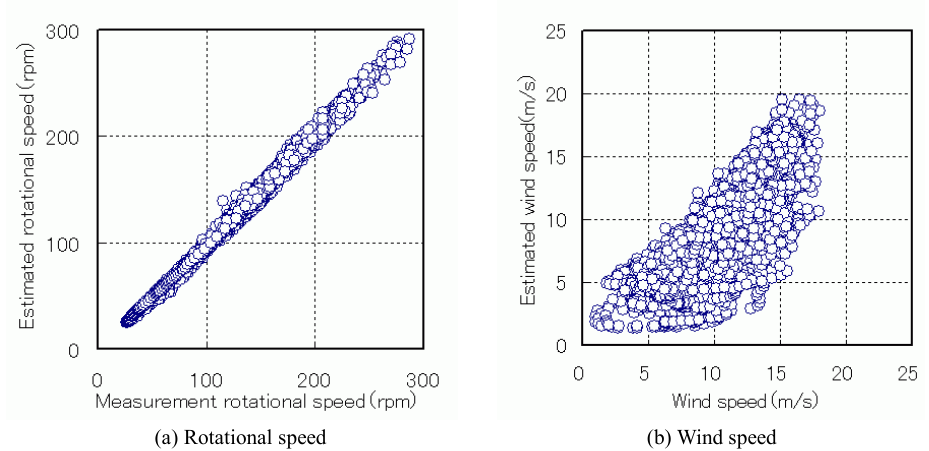
Figure 8 Comparison of state parameter and estimated parameter of Kalman filter